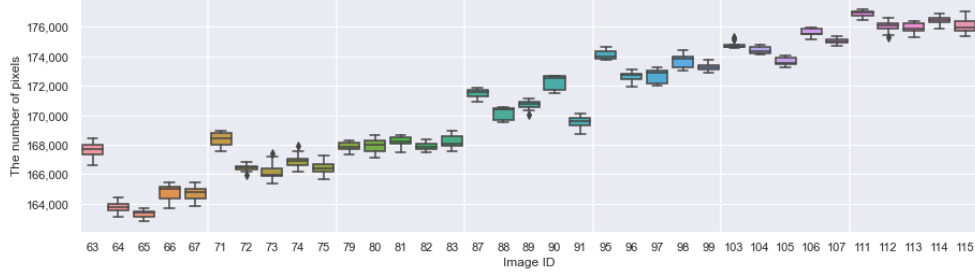
Figure A2. 20–26 August.